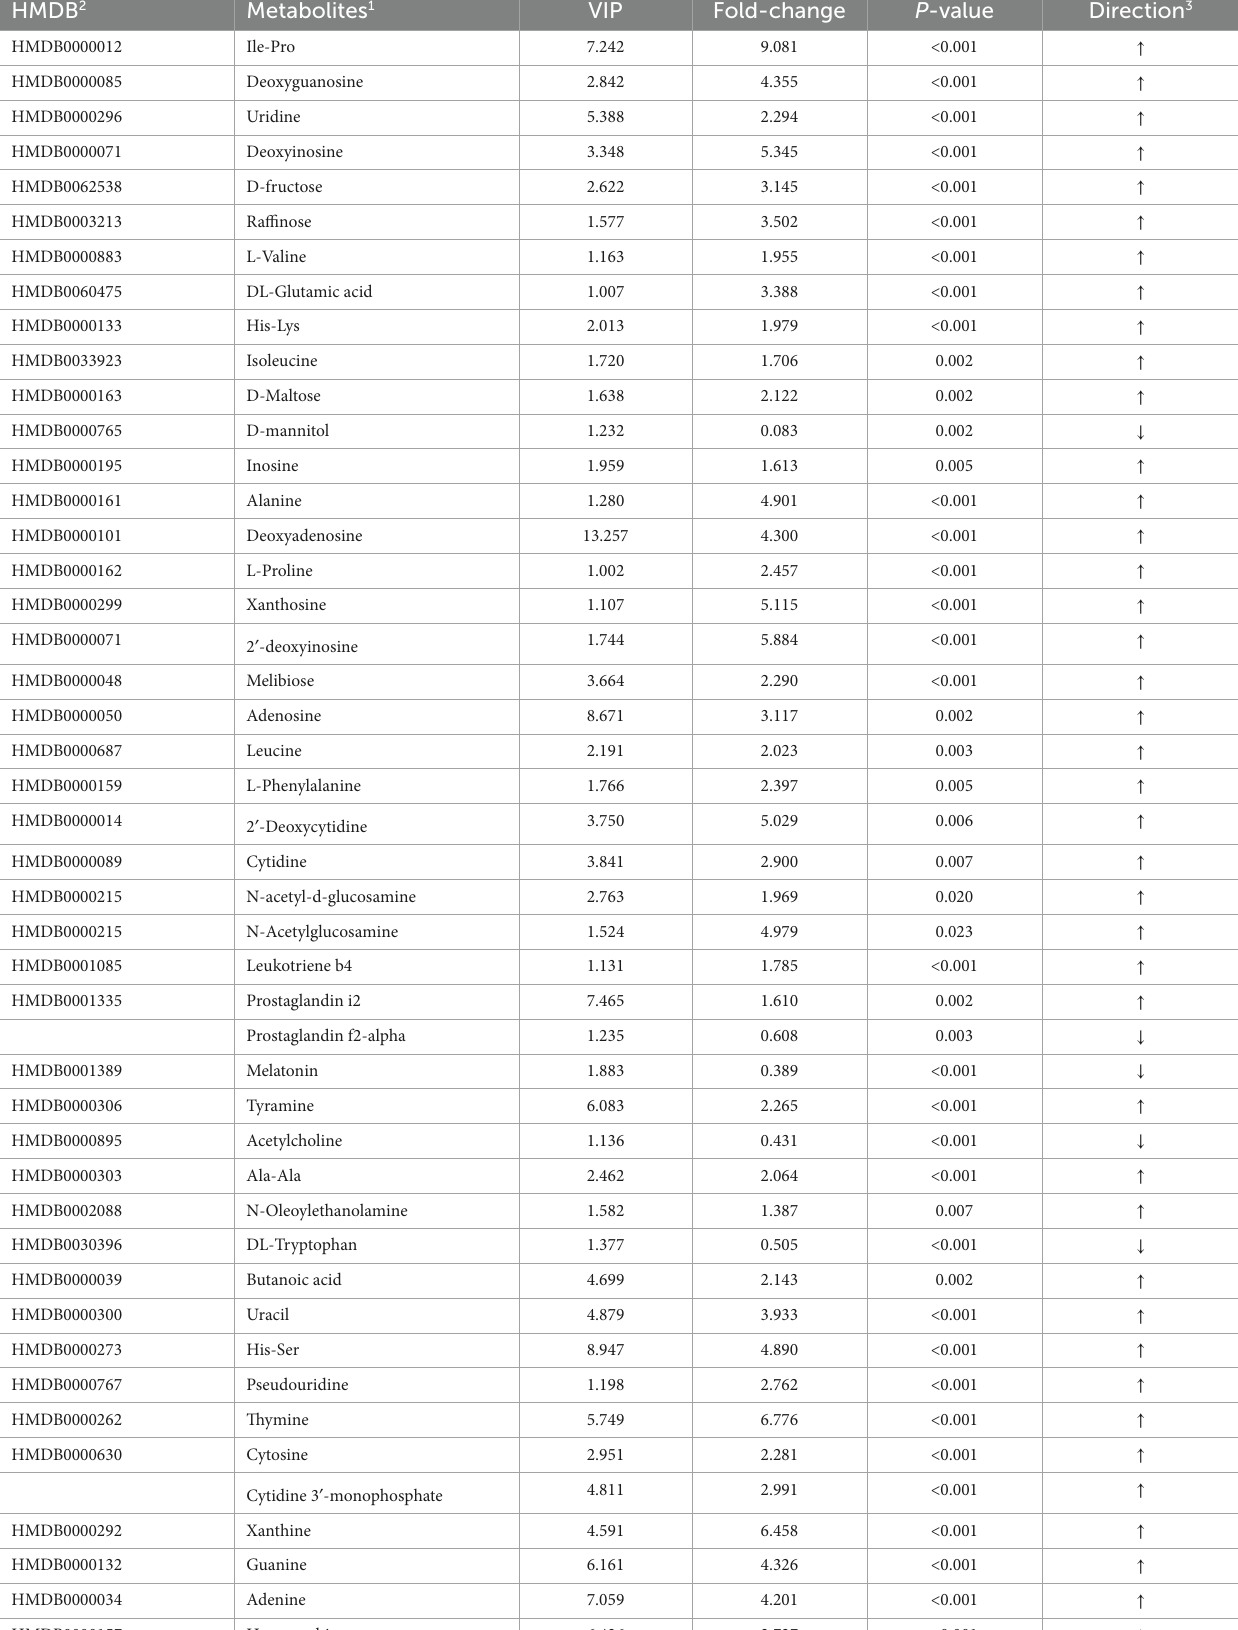
TABLE 4 Differential metabolites in differential enriched KEGG pathways using HILIC-MS analysis. HMDB